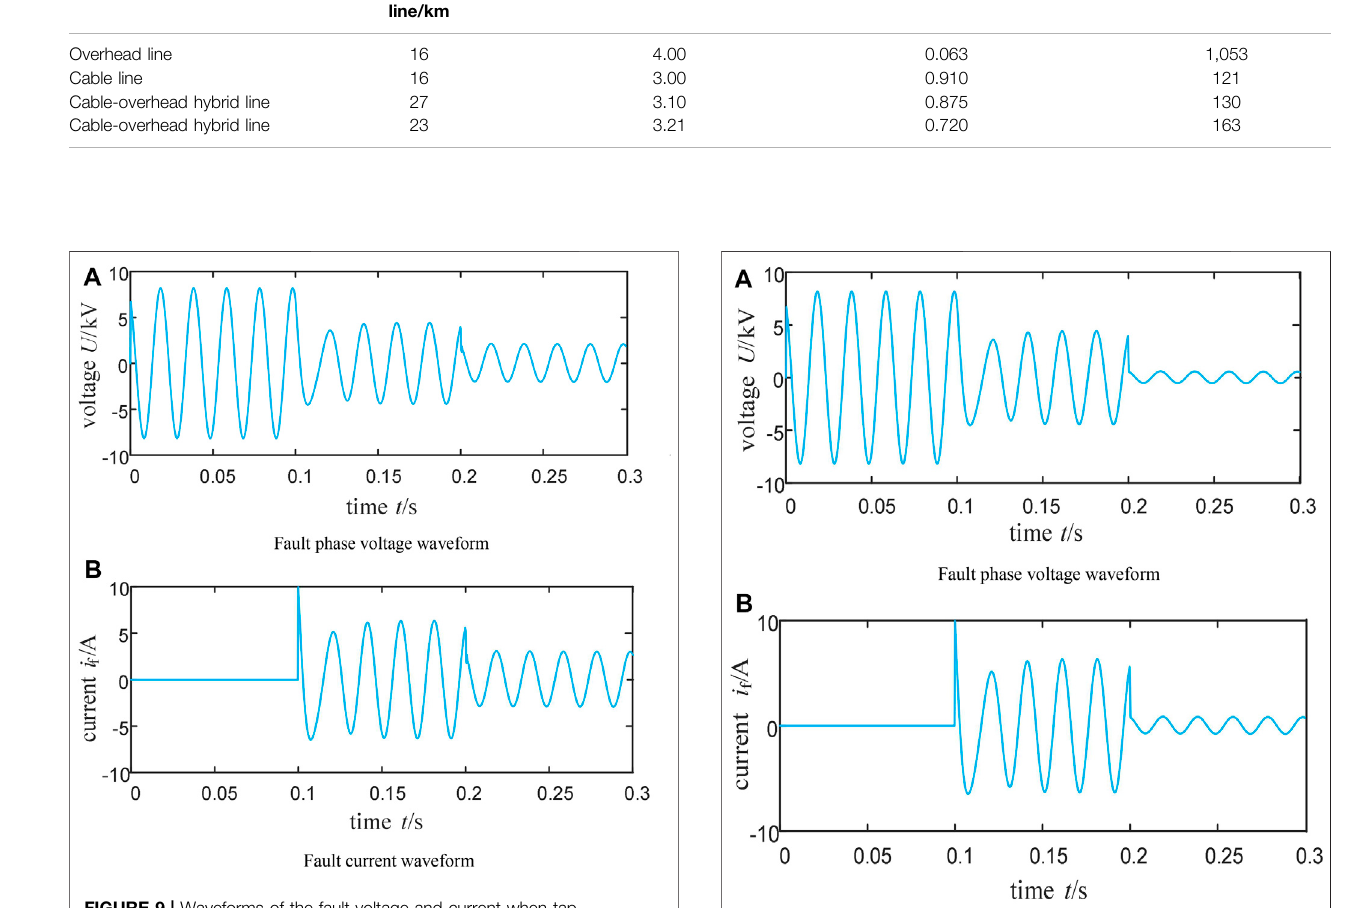
FIGURE 9 | Waveforms of the fault voltage and current when tap position is at initial tap position minus 1. (A) Fault phase voltage waveform (B) Fault current